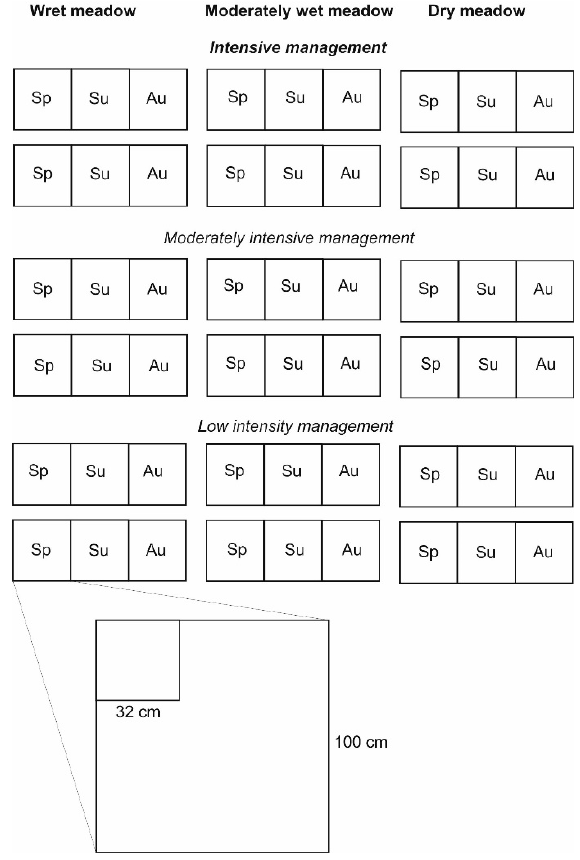
Figure 1. Sampling design. Each plot is divided into two subplots: 1 m2 (100 cm x 100 cm) and 0.1 m2 (32 cm x 32 cm). Abbreviations: Sp – spring, Su – summer, Au – autumn. 0.1 m 2 (32 cm × 32 cm). Abbreviations: Sp—spring, Su—summer,